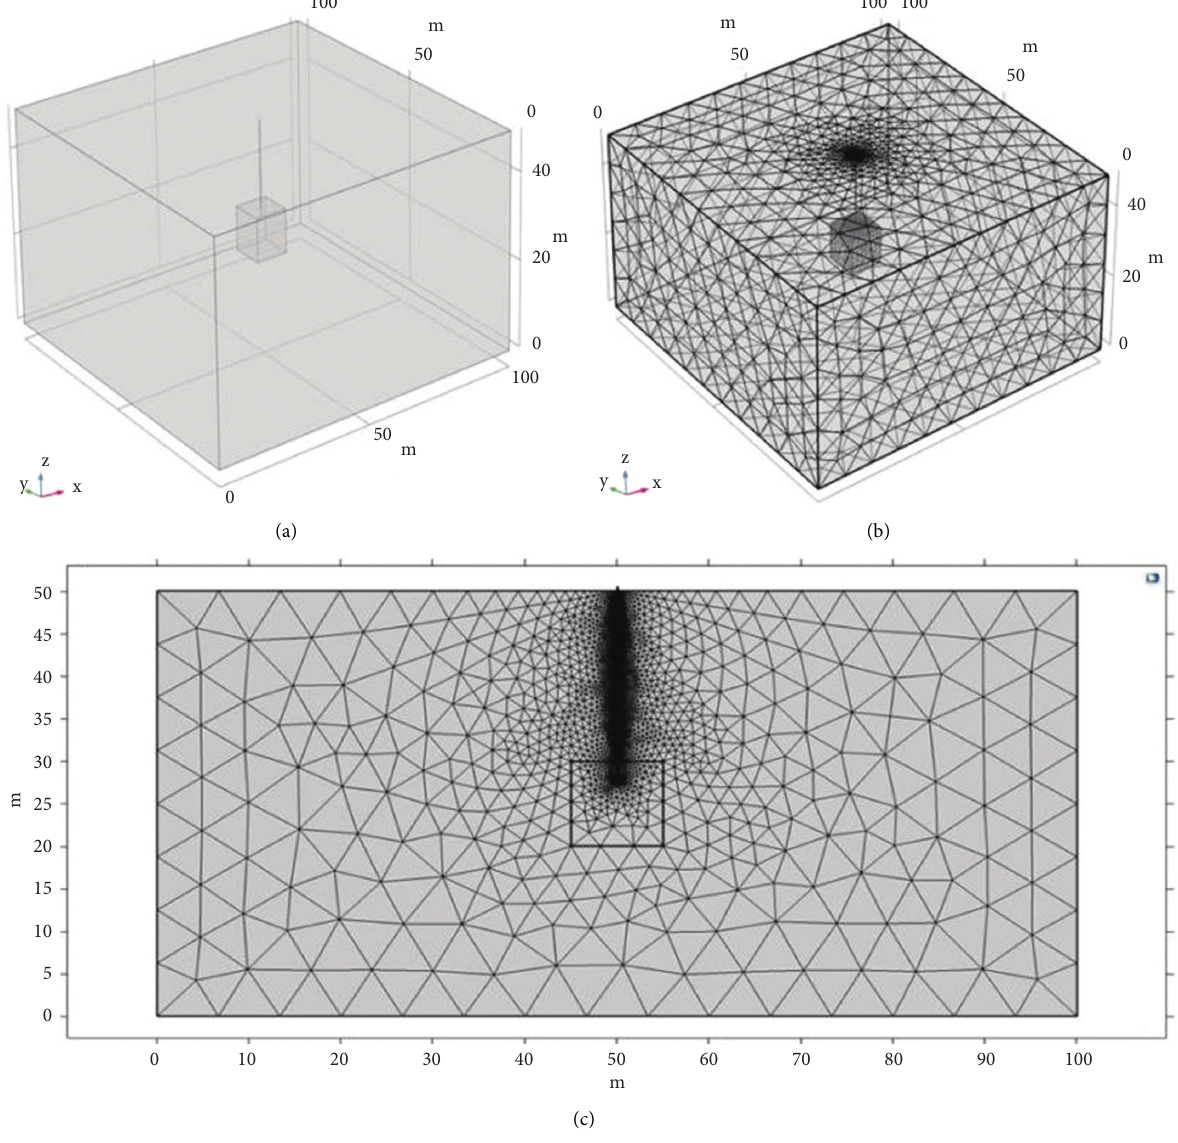
Figure 2: Single-cavity fault-controlled karst fracture-cavity reservoir geological model (a), geological model grid (b), and two-dimensional grid unit along the longitudinal section of the well center